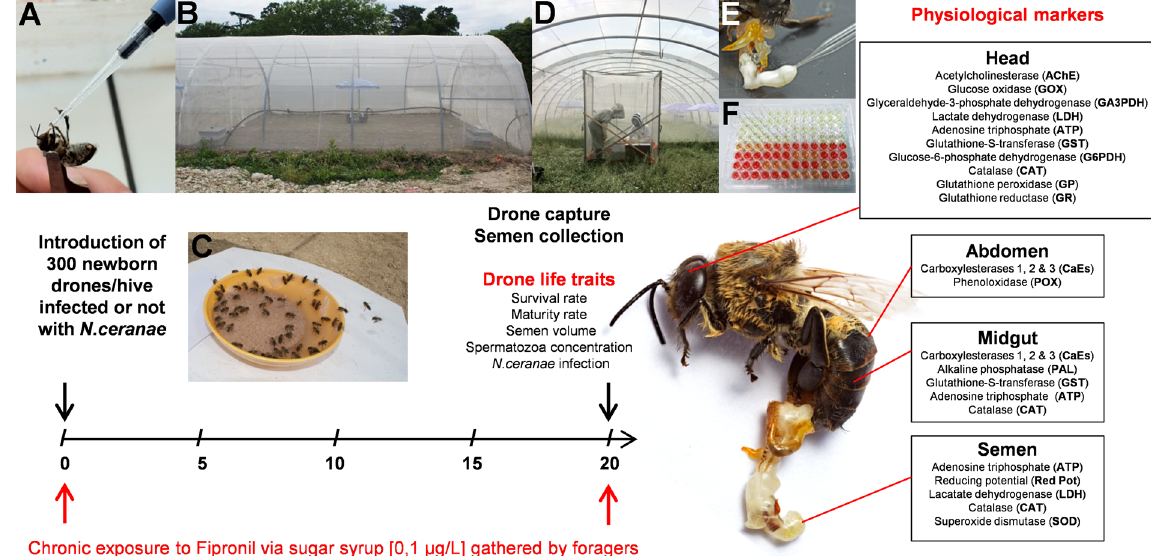
Figure 1. Experimental design. Drones were exposed to the pathogen N. ceranae , the insecticide fipronil or both under semi-field conditions. Newborn drones were individually fed a sugar syrup solution contaminated or not with 50,000 spores of N. ceranae ( A ) and cloistered in queenless colonies placed under a tunnel covered with an insect-proof net ( B ). For 20 days, colonies were supplied daily by foragers that gathered in a feeder